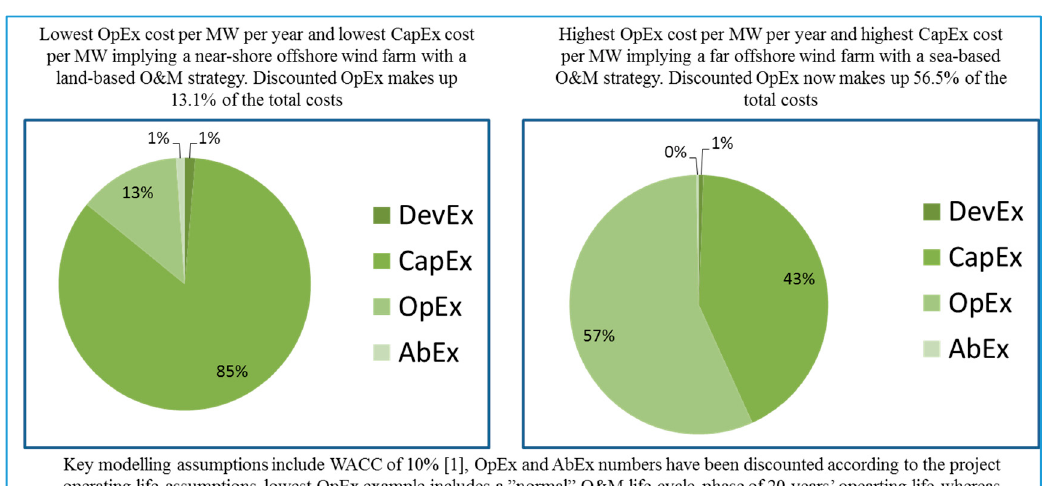
Figure 3. Scenarios displaying fluctuations in Operating Expenditure share of total costs.